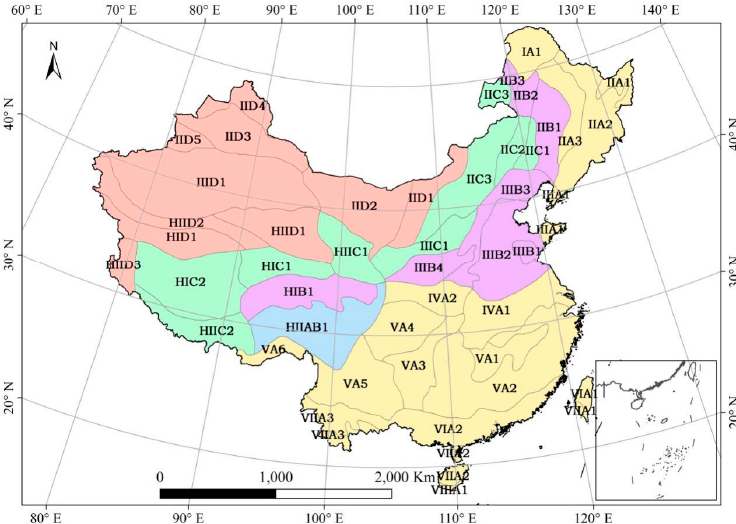
Figure A2. The topographic zones over mainland China. ( IA1 —Greater Khingan Range, IIA2 —mountain area in the eastern part of Northeast China, IIB3 —the foothills of the piedmont of the Sanhe